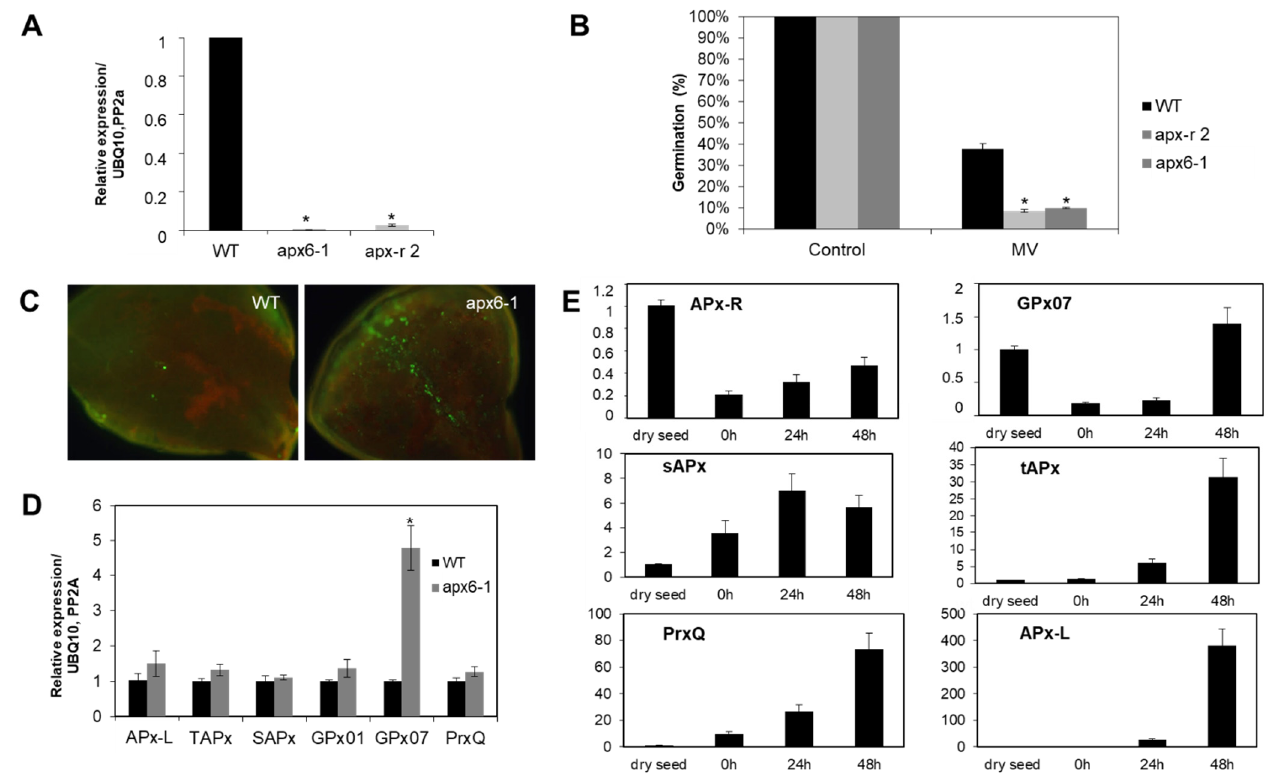
Figure 3. APx-R participates on chloroplast antioxidant defense. ( A ) Relative expression of AtAPx-R (At4g32320) gene on 10-day-old wild-type, apx6-1 (CS851165) and apx-r 2 (CS859356) seedlings. ( B ) Average germination rate of apx6-1, apx-r 2, and wild-type seeds in the presence of 0.5 µM methyl-viologen. Values are the mean of three biological replicates ( n = 50). ( C ) Ten-day-old apx6-1 and wild-type seedlings were exposed to 1 µM methyl-viologen for 12 h and reactive oxygen species (ROS) accumulation was analyzed after incubation with the fluorescent probe 2 ′ ,7 ′ -Dichlorodihydrofluorescein diacetate (DCFDA). ( D ) RT-qPCR analysis performed on 10-day-old plants shows the upregulation of glutathione peroxidase 7 (GPx07), whereas other chloroplast peroxidases encoding genes were not affected in apx6-1. ( E ) Relative expression of chloroplast peroxidases throughout germination in wild-type Col-0 seeds evaluated by RT-qPCR. Four time points were analyzed: dry seed, 0 h (after stratification), and 24 and 48 h into photoperiodic illumination. All gene expression analyses were normalized by two reference genes: PP2A and UBQ10. Each time point consisted of three biological replicates and four technical replicates. At least two independent experiments were performed. * Significant difference according to Student’s t-test ( p < 0.05).